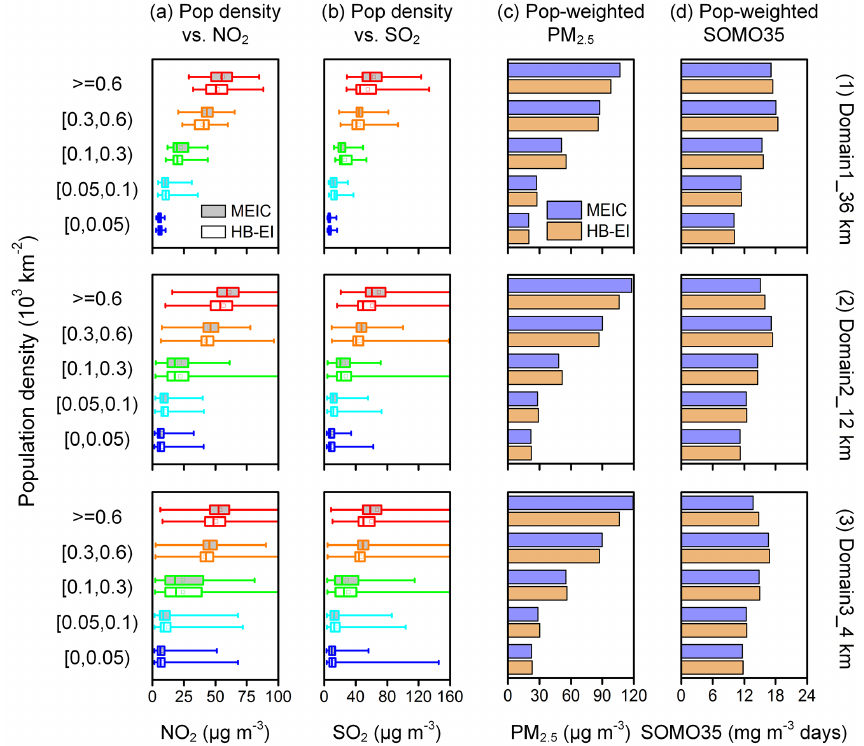
Figure 7. Air pollution distributions and exposures by population density at 36, 12, and 4km: (a) NO 2 , (b) SO 2 , (c) population-weighted PM 2 . 5 , and (d) population-weighted SOMO35. Note that the SOMO35 is used to evaluate the health risk of O 3 according to Amann et al.